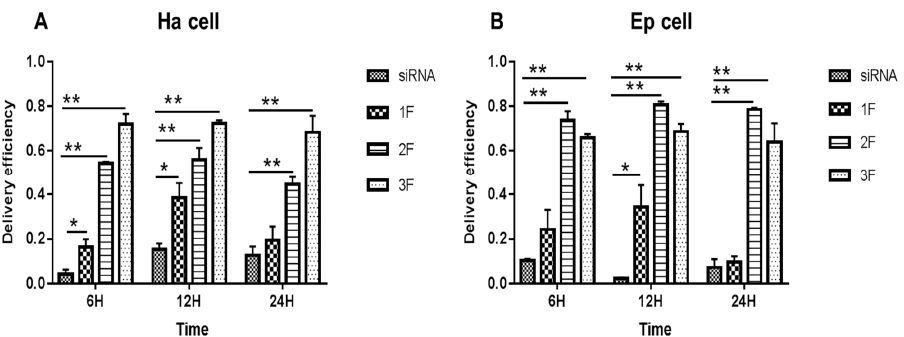
Figure 2. In vitro delivery efficiency of FNP–siRNA in two cell lines. ( A ) Delivery efficiency in H. armigera Ha cells. ( B ) Delivery efficiency in H. armigera Ep cells. 1F, 2F, and 3F indicate FNP:siRNA amount ratios 1:1, 2:1, and 3:1, respectively. Data are mean ± SD. Asterisks “**” and “*” indicate significance at p < 0.01 and p < 0.05 levels, respectively. After 6–24 h transfection in darkness, fluorescence in FNP-siRNA transfected cells was imaged. The delivery efficiency was calculated as the percentage of fluorescent cells to total cells.